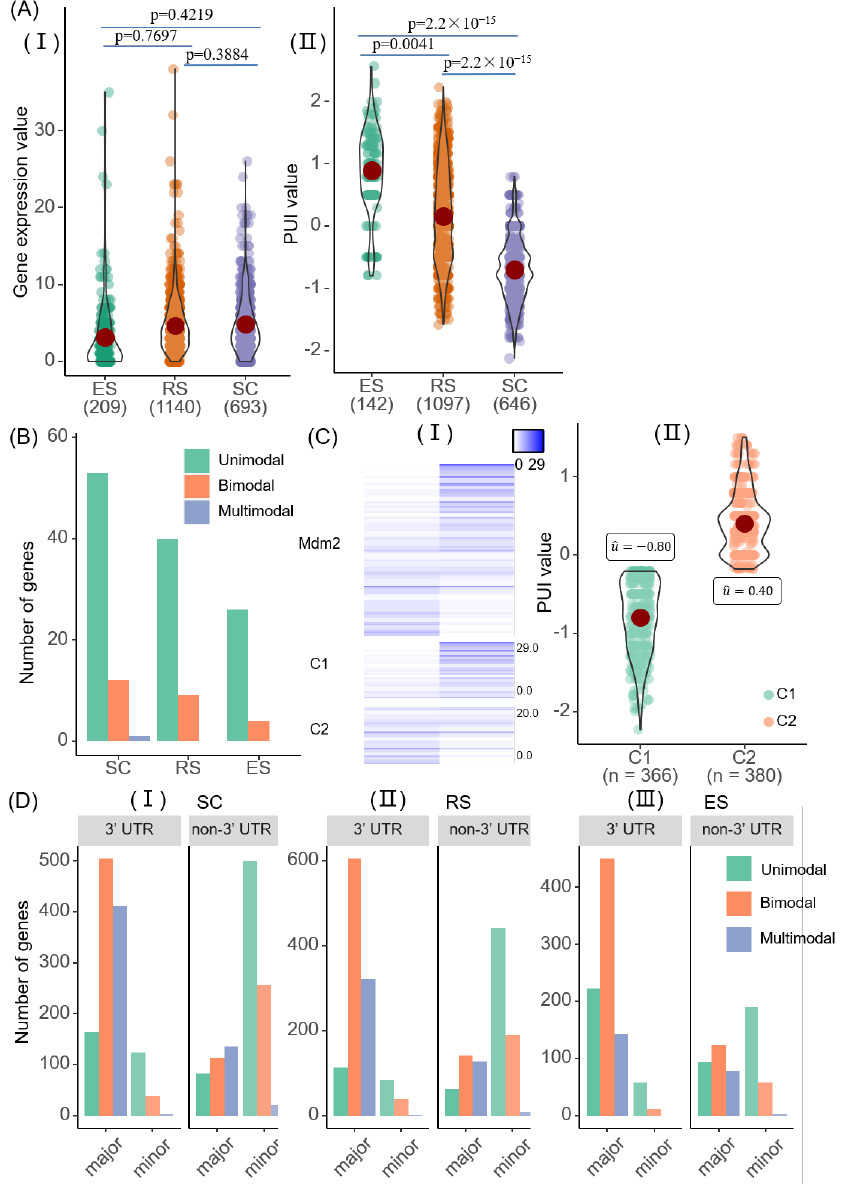
Figure 3. The 3′ UTR APA modality. ( A ) Gene expression (I) and APA usages (II) during mouse spermatogenesis differentiation of gene Mdm2 . ( B ) Modalities identified using scAPAmod for of 3′ UTR-APA genes in each stage. ( C ) Two components of the GMM model (C1 and C2) of the bimodality of gene Mdm2 . The heatmap of poly(A) site expression (I) and boxplot representation of PUI data (II) of the Mdm2 gene. The upper part of the heatmap shows the expression of the two poly(A) sites of the gene in different cells. The lower part shows the expression of poly(A) sites belonging to each component of the gene in different cells. Here, the C1 component had 366 cells and the C2 had 380 cells. ( D ) Comparison of modalities identified for major poly(A) sites and minor poly(A) sites in 3′ UTR and non - 3′ UTR across stages in SC (I), RS (II) and ES (II) stage.